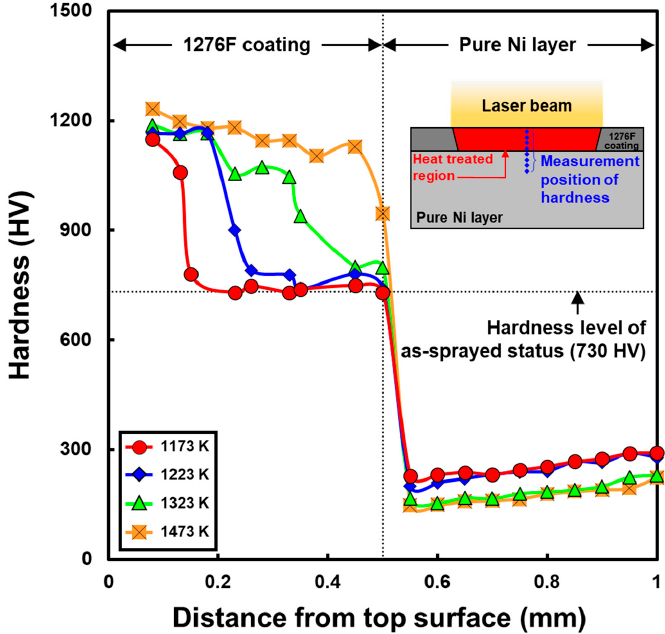
Figure 6. Hardness distribution of thermal-sprayed layer after laser-assisted fusing treatment.